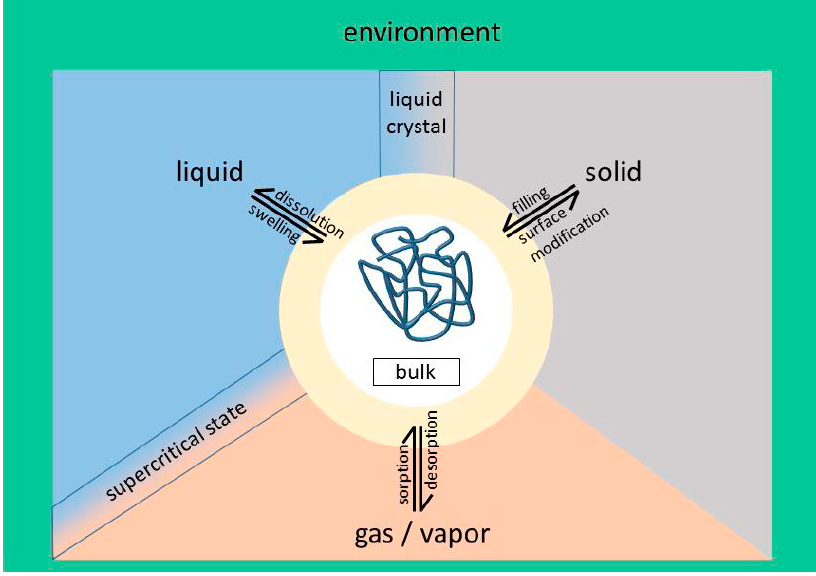
Figure 1. Schematic representation of possible interactions of polymers with their environment.